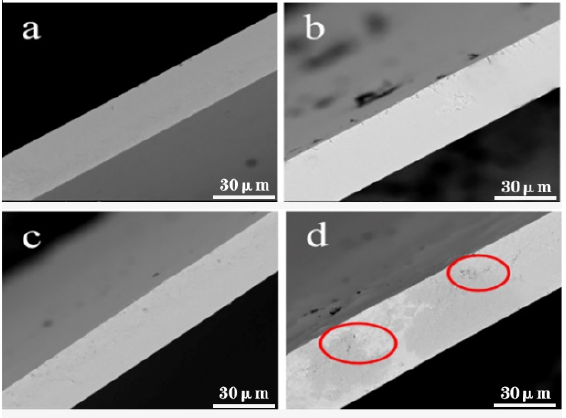
Figure 9. Cross-sectional morphology of films; ( a ), PBAT film, ( b ), PSC-0.5%, ( c ), PSC-2.5%, ( d ), PSC-